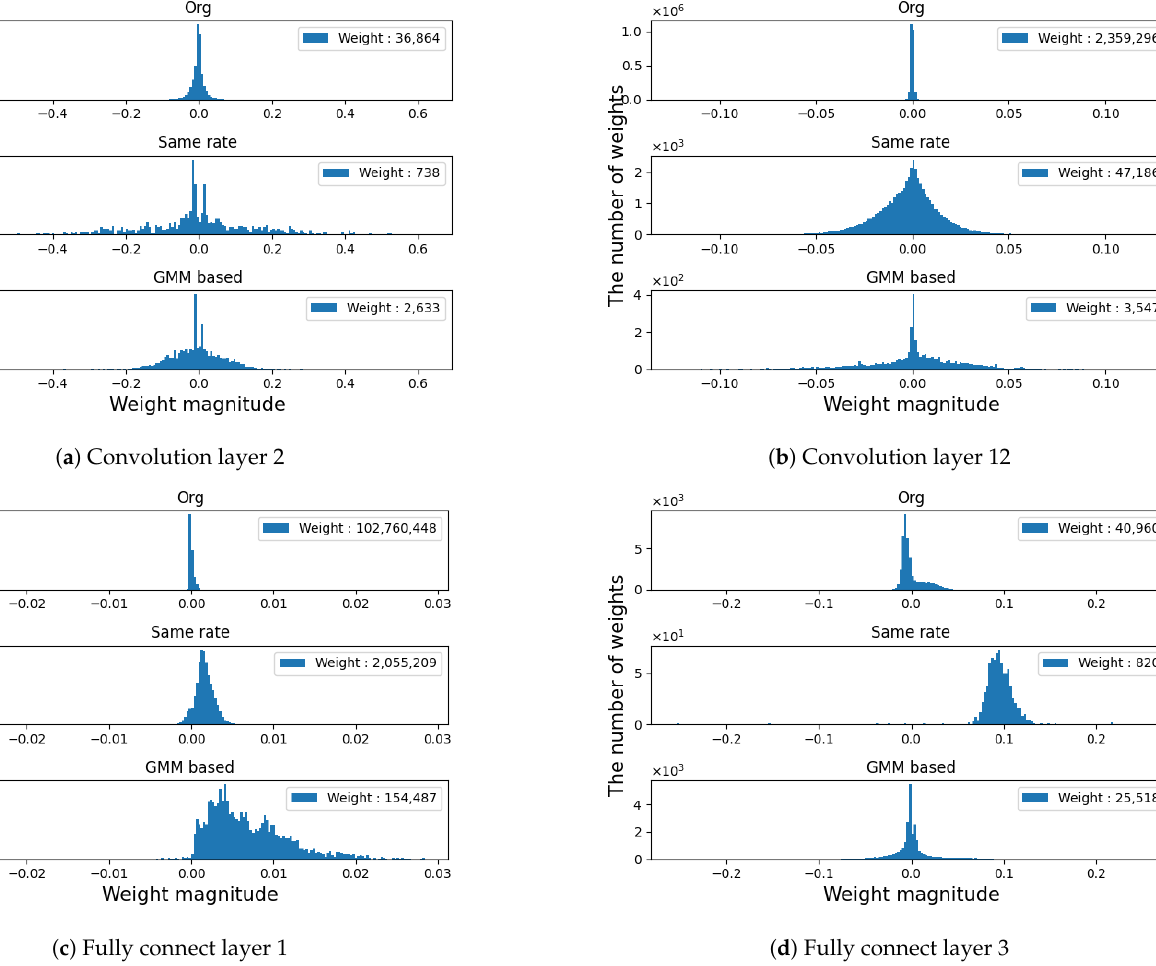
Figure 8. Compare the weight distribution between original network, network that pruned with the same rate and network that pruned based on GMM. On the layers with less weights, like ( a , d ), a network applying the same rate maintains a few weights, so it can cause network to suffer to train. However, GMM-based pruning leaves sufficient weights, and the network can be trained more easily. On the other hand, at the layers with a lot of weights, such as ( b , c ), a network using same rate pruning method has more redundancy of weights. But, when adopting the GMM-based pruning method, redundancy weights are fairly